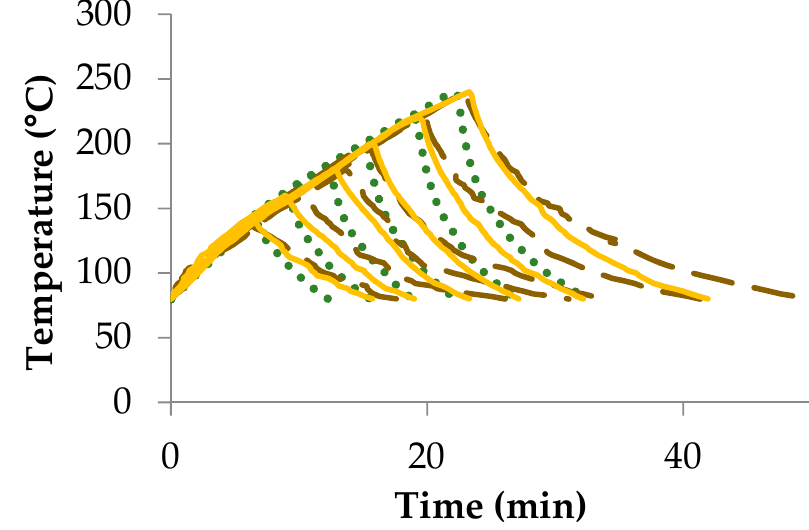
Figure 1. Temperature profile of different experiment of Paulownia bark (dashed line), leaves (dotted line), and petioles (continuous line).